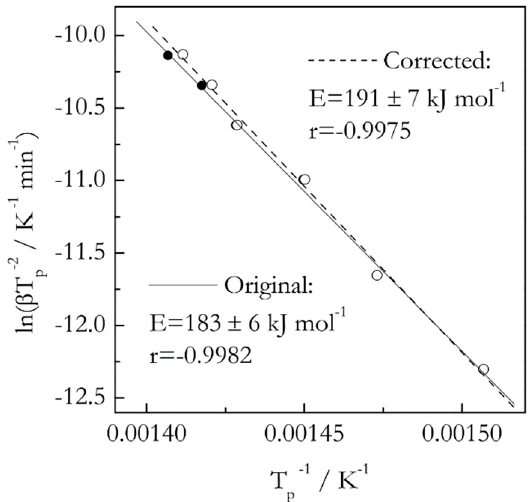
Figure 1. Kissinger plots for thermal degradation of isotactic polystyrene. Data from Liavitskaya and Vyazovkin [18] and Vyazovkin [16]. Solid and open circles represent T p values obtained respectively from original (raw) data and data corrected for thermal inertia. The difference is obvious only for faster heating rates, 16 and 20 °C min − 1 . Solid and dash lines are the least square fits to original and corrected data.